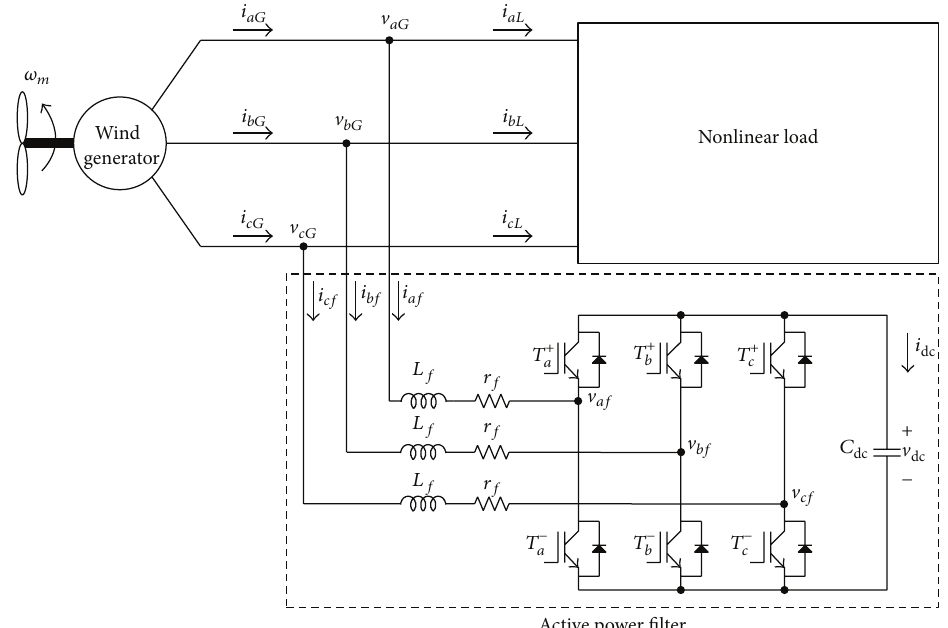
Figure 1: Block diagram of the proposed system.